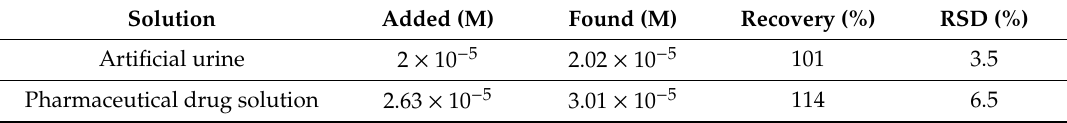
Figure 10. Standard addition method for the determination of DA concentration in artificial urine ( a ) and pharmaceutical drug solution ( b ). Table 3. Determination of DA concentration in artificial urine and pharmaceutical drug